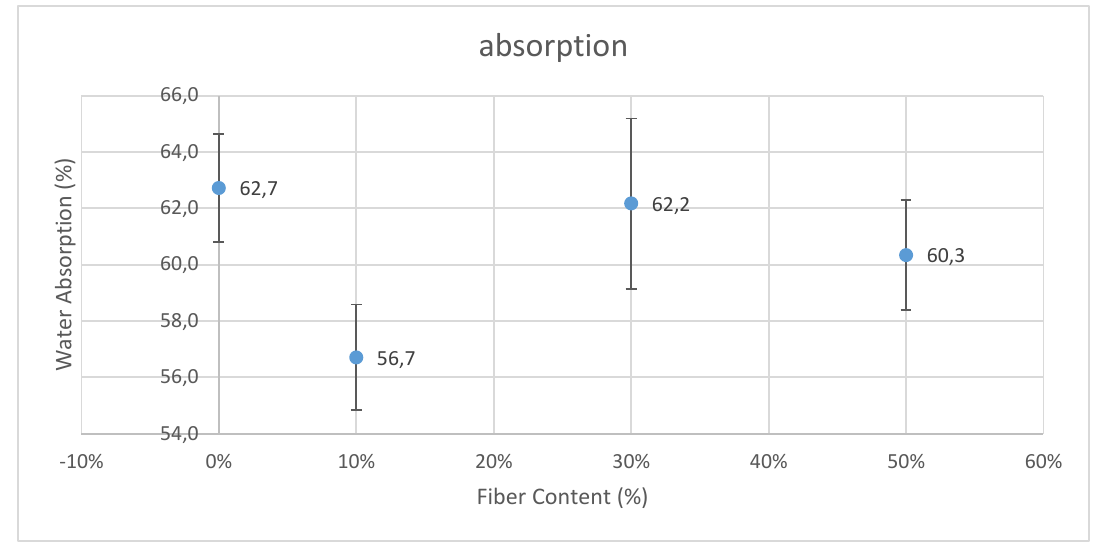
Figure 7: The absorption coeflcient of geopolymer foams with increasing basalt waste fibre concentration.